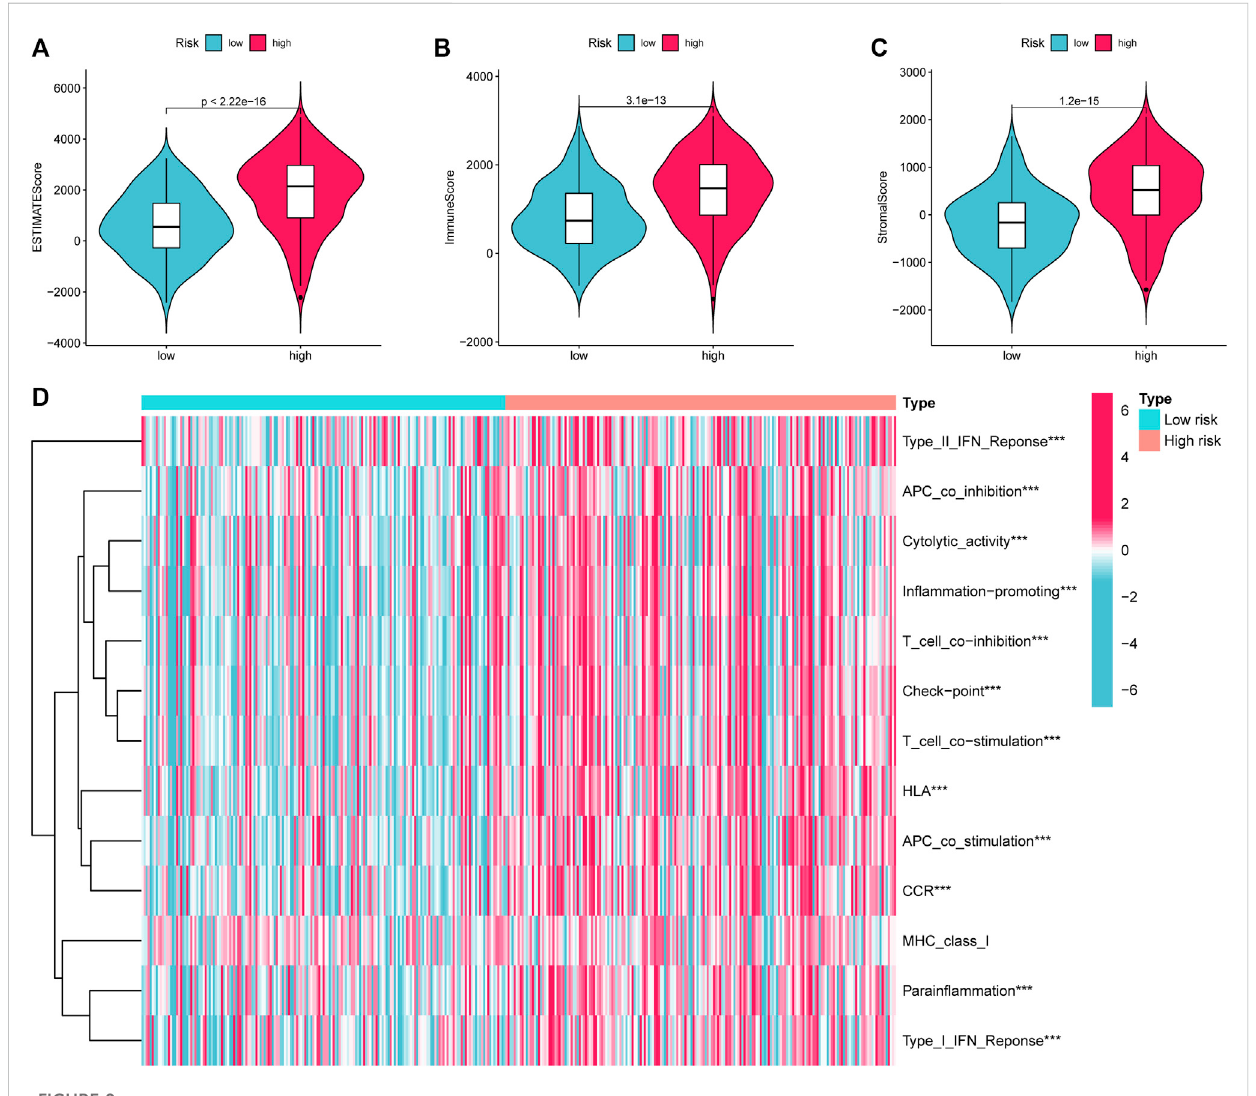
FIGURE 9 ESTIMATE calculatesthepurity ofSTAD. (A) EstimateScore (B) .ImmuneScore (C) .StromalScore. (D) Variationsinimmune functionacrosshighand low-risk categories calculated by ssGSEA algorithm. STAD, Stomach adenocarcinoma; ssGSEA, single-sample gene set enrichment analysis. * p < 0.05; ** p < 0.01; *** p <